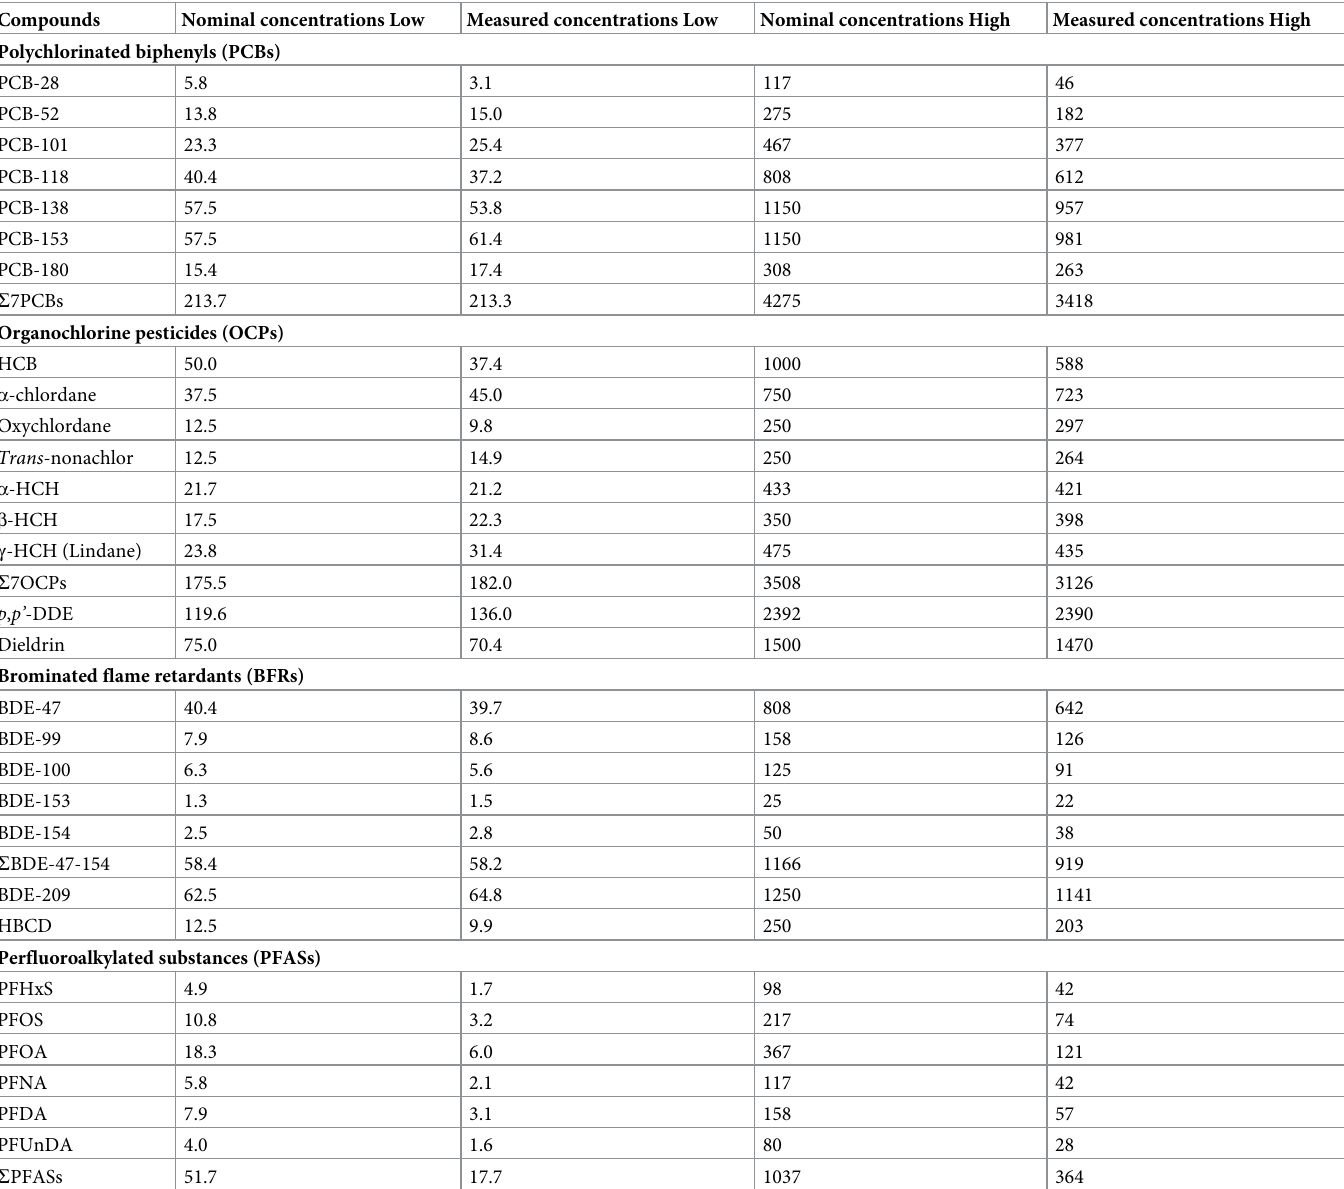
Table 1. POP concentrations in